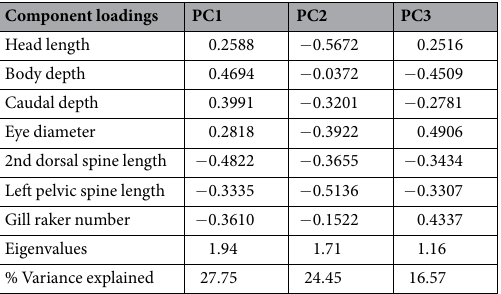
Table 1. Principal component (PC) analysis of morphological